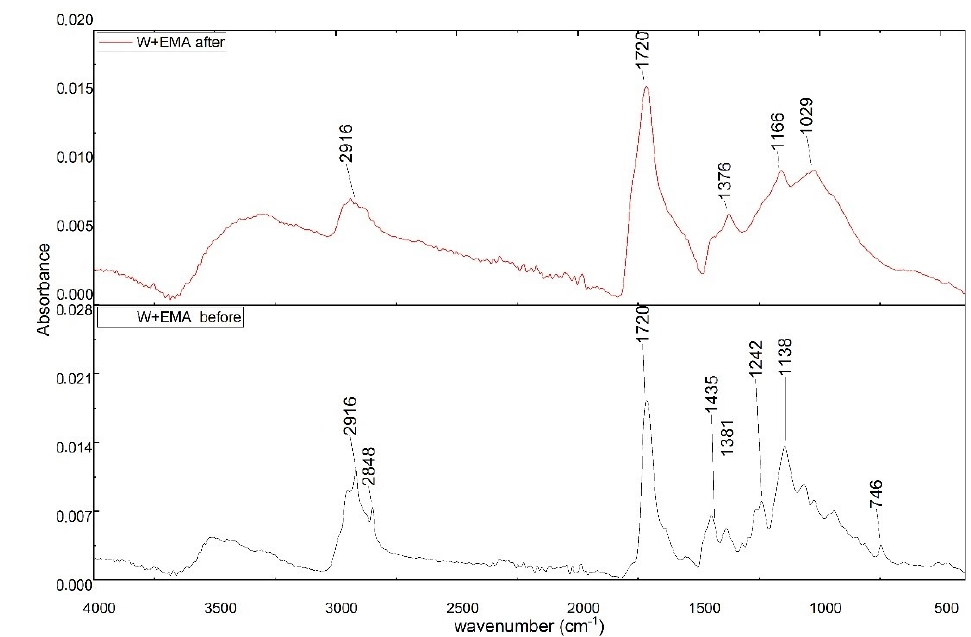
Figure 6. Changes to the chemical structure of W+EMA and W+MMA samples before and after the UV-C irradiation.